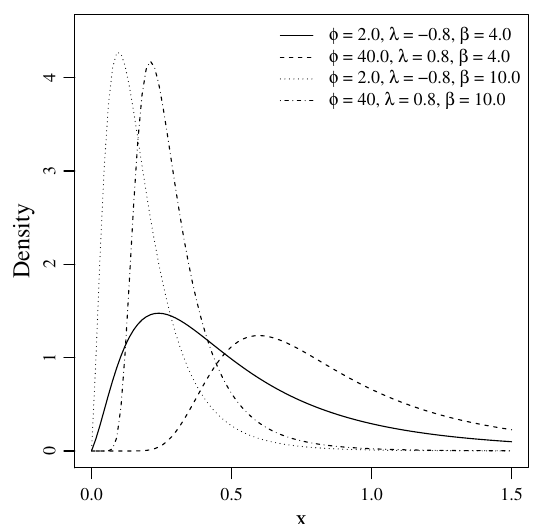
Figure 1. Examples of density formats of the ET-IB distribution for α =